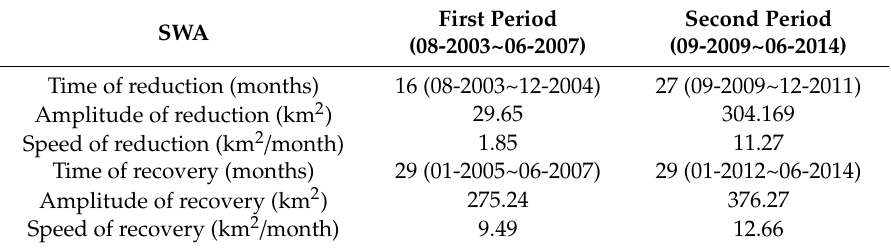
Table 2. Variations of seasonal water area (SWA) in two drought